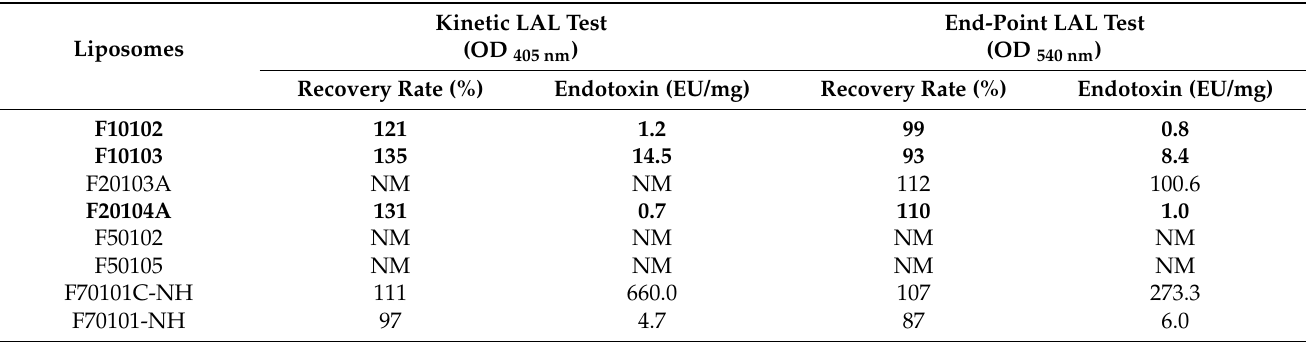
Table 3. Endotoxin contamination of liposomes measured by two chromogenic LAL tests. Endotoxin contamination levels are expressed in EU/mg liposomes. In italics, endotoxin evaluations hampered by the significant interference of liposomes with the assays’ readouts (see Figure S2). NM, not measurable. Only three liposomes (bold) were selected for the functional experiments, which are highlighted in